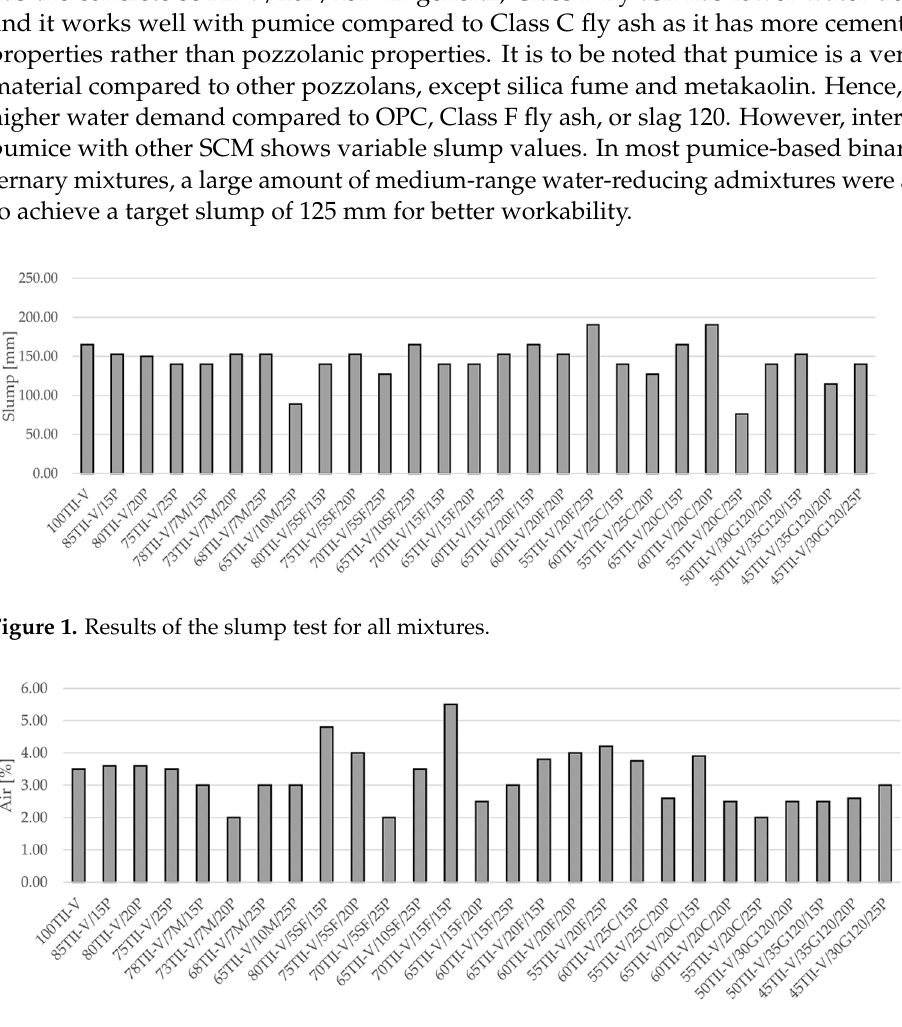
Figure 2. Results of the air content for all mixtures.